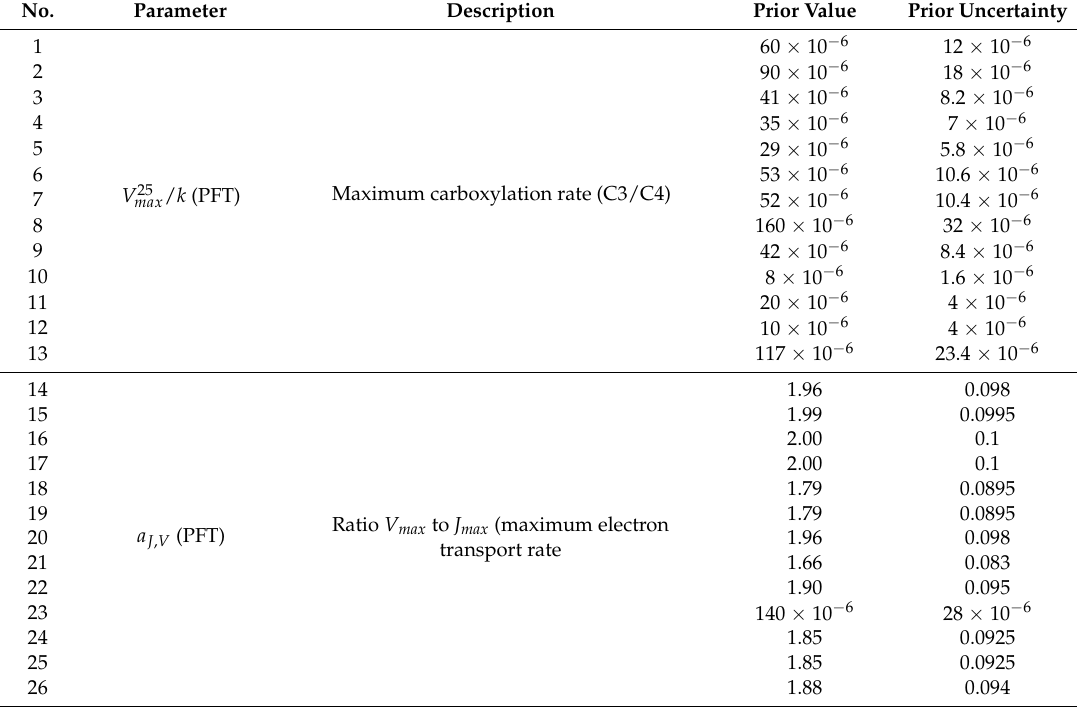
Table A2. Parameters to be calibrated in CCDAS, with prior values and uncertainties, parameters could be classified as PFT specified, soil texture specified, and global parameters that all sites share one value, as denoted after each